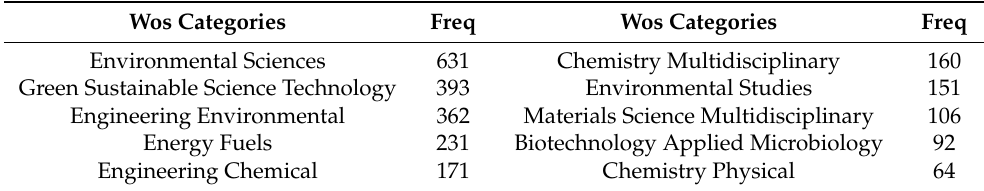
Table 1. Table of Top 10